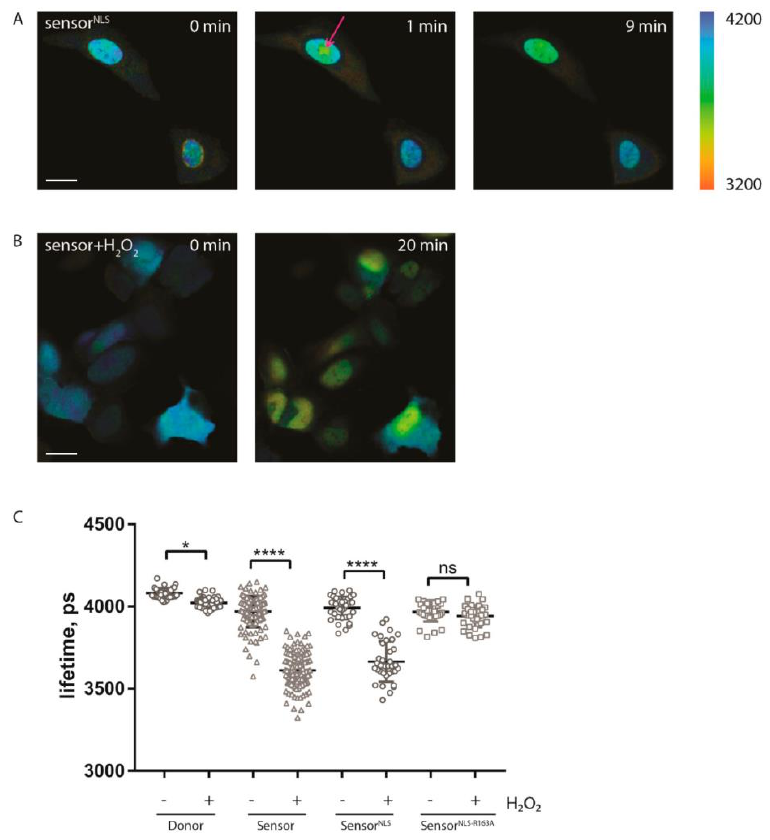
Figure 2. FLIM-based monitoring of sPARroW response. ( A ) U2OS cells, transiently expressing sPARroW NLS and locally irradiated with a 405 nm laser; irradiation site is indicated with an